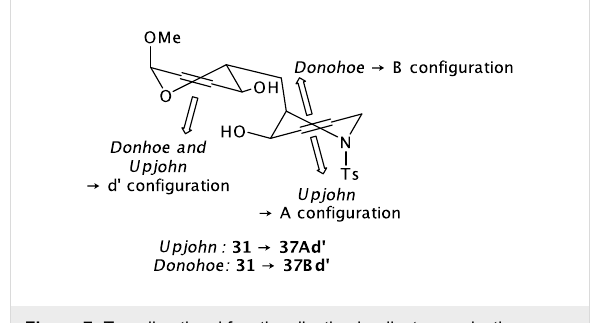
Figure 7: Two-directional functionalisation by diastereoselective dihydroxylation